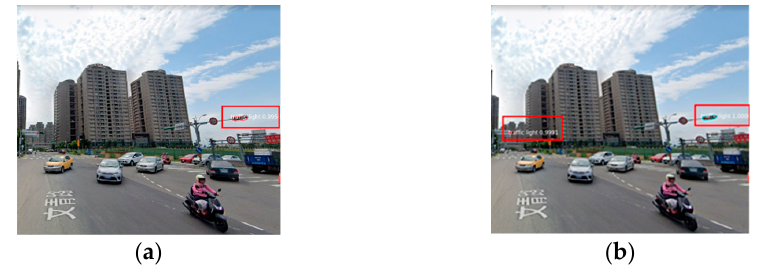
Figure 8. Recognition results from trained models: ( a ) without data augmentation; ( b ) with data augmentation.